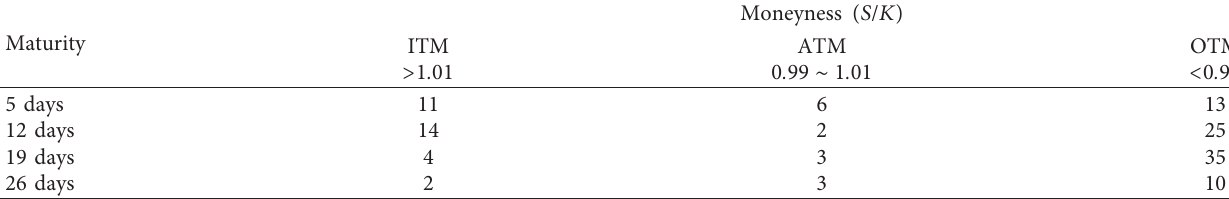
Table 4: Numbers of AAPL option data.